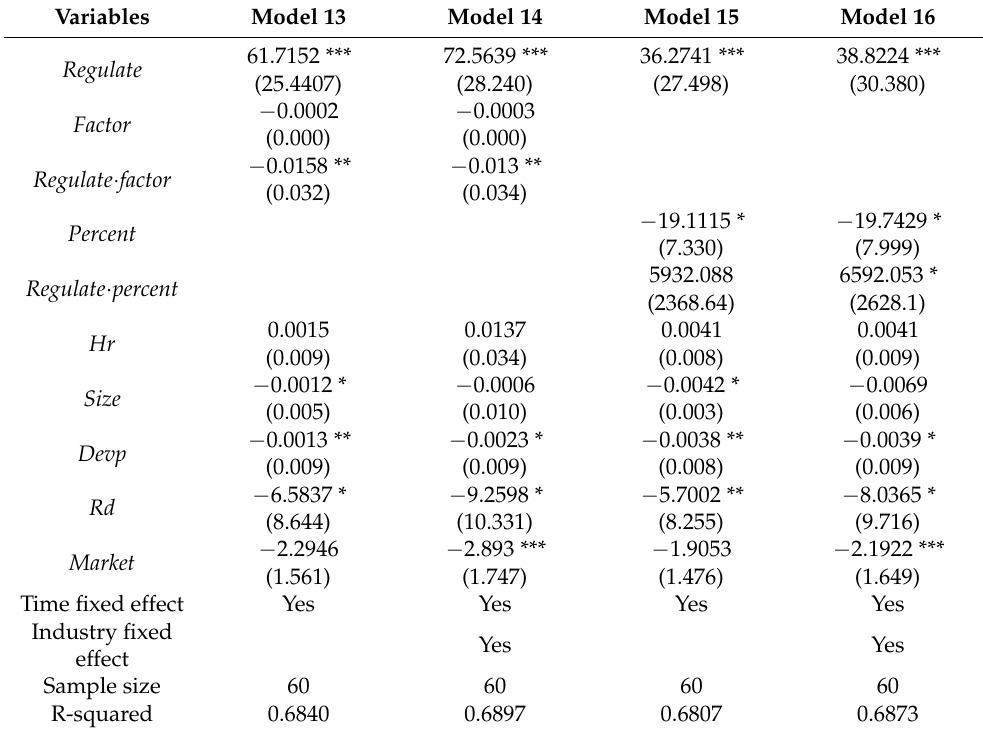
Table 6. Heterogeneity regression results from a cost